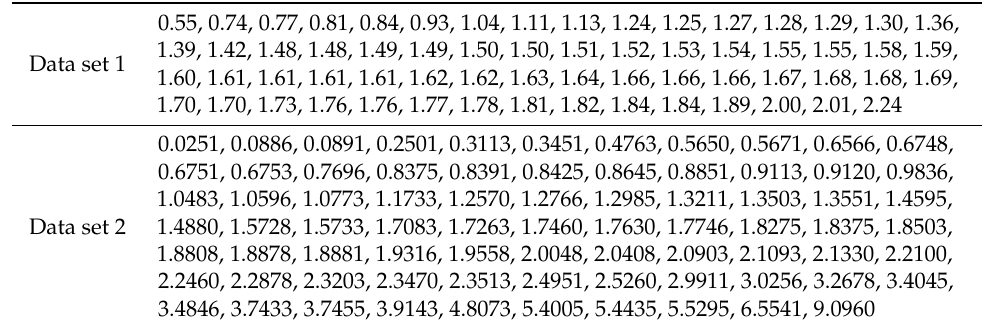
Table 2. The engineering data